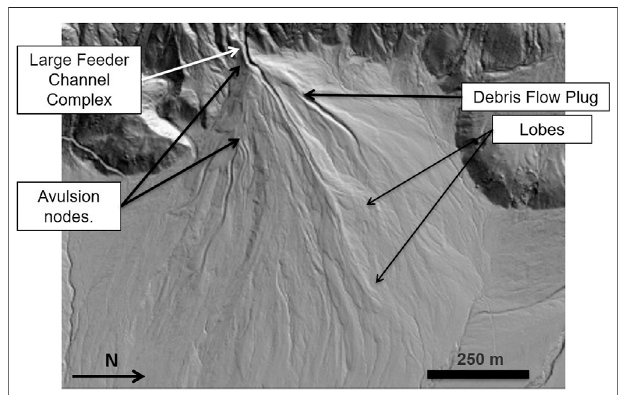
FIGURE 12 | Hill-shade map based on LiDAR produced topography of subaerial debris fl ow dominated fan inSaline Valley,California. Laminar fl owof the subaerial debris fl ows has produced a surface distributary texture with long, nearly straight channels, sparse branching points, and narrow depositional bodies. This distributive architecture is reminiscent of LE3 ( Figure 8 ).Source: Earthscope Eastern and Southern California. Resolution